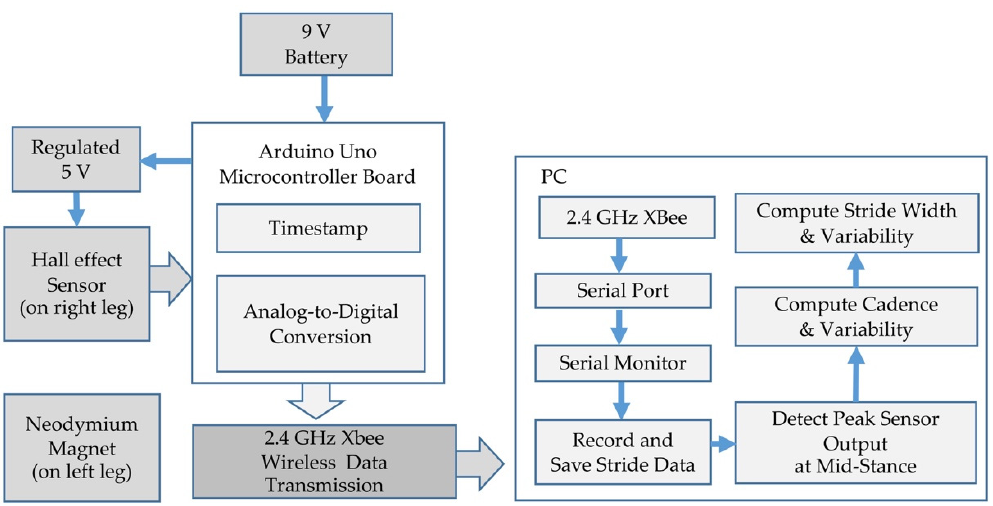
Figure 1. Block Diagram of Wearable Gait Monitoring System.